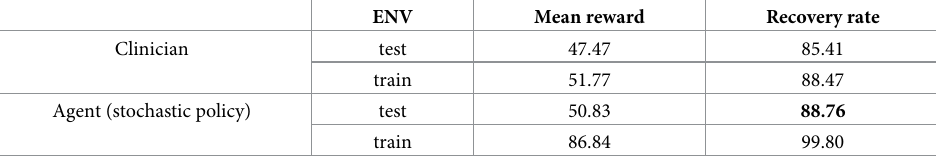
state parameterized by the specified radius. States outside of this neighborhood are mapped to the upper half of the sphere, with states infinitely far away from the center being mapped to its north pole. This new state representation can then be colored following results from the algo- rithm. We represent state-values (i.e. maximal expected q -values across actions) in Fig 6b and Table 1. Performance comparison of the agent and the clinicians after 10 000 simulated patient trajectories in the evaluation environment ( n = 10000, 90-day mortality).